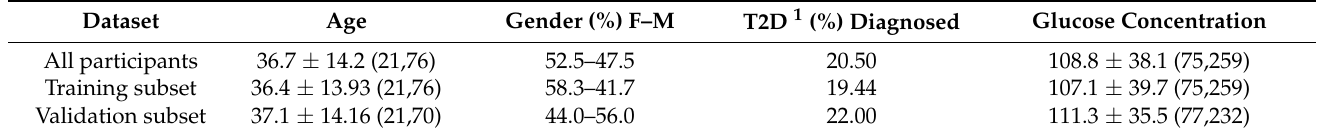
Table 1. There, the average ± the standard deviation and the (min, max) range regarding the age and glucose concentration of participants are described. The percentages of female and male participants and for those diagnosed with T2D are also reported. Table 1. Details of the participants per